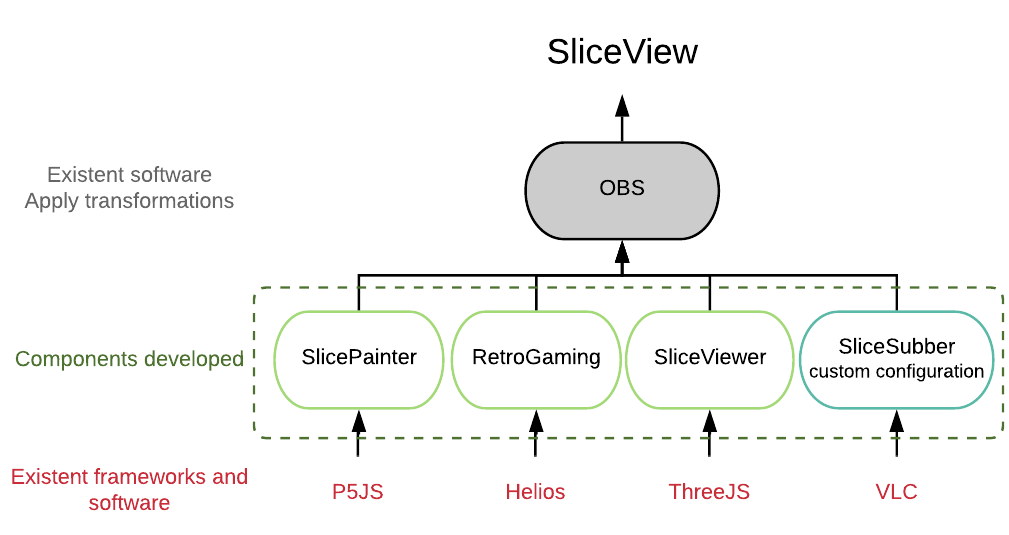
Figure 2. Component diagram showing modified and employed